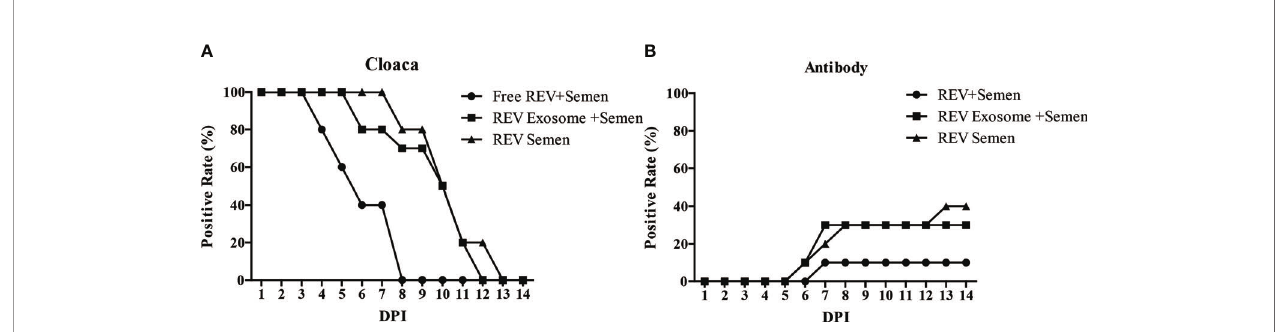
FIGURE 5 | Effects of free REV and REV exosome on hens by arti fi cial insemination. (A) REV-positive rate of cloaca after arti fi cial insemination during 1 to 14 dpi. (B) REV-antibody-positive rate of hens after arti fi cial insemination during 1 to 14 dpi.